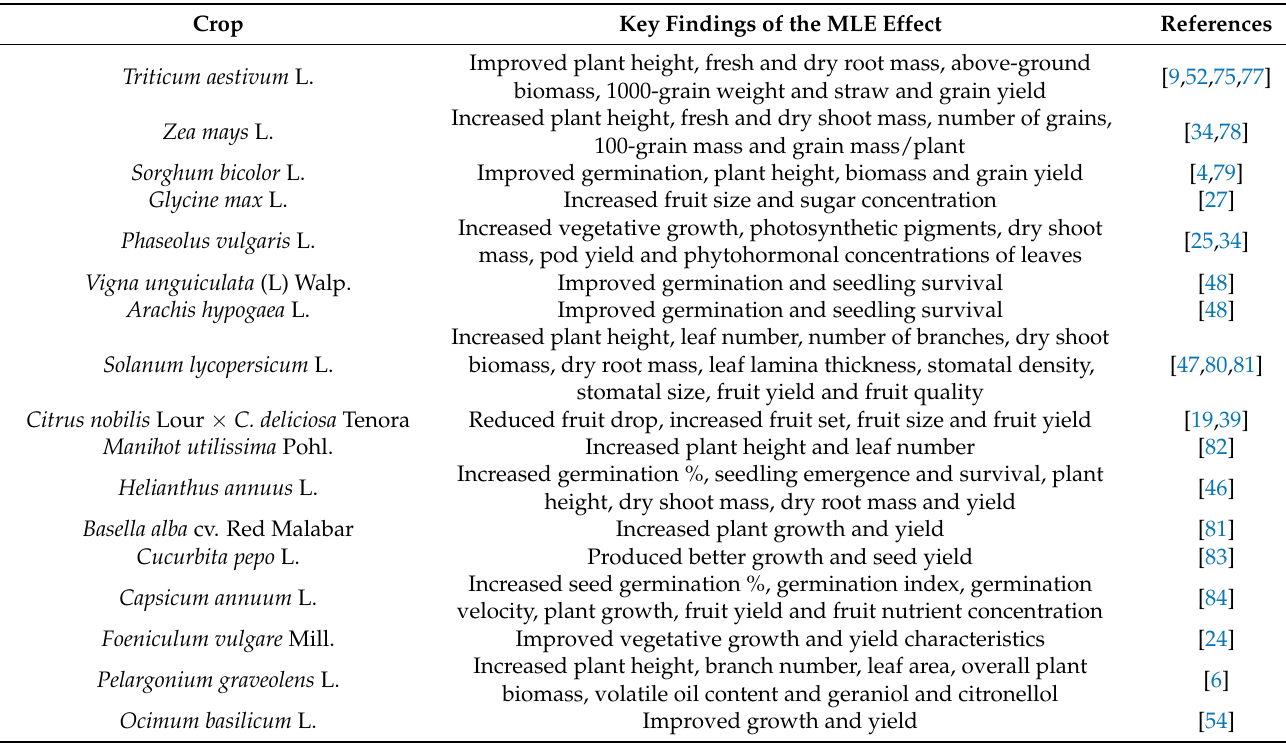
Table 4. Effect of applying moringa leaf extract to various